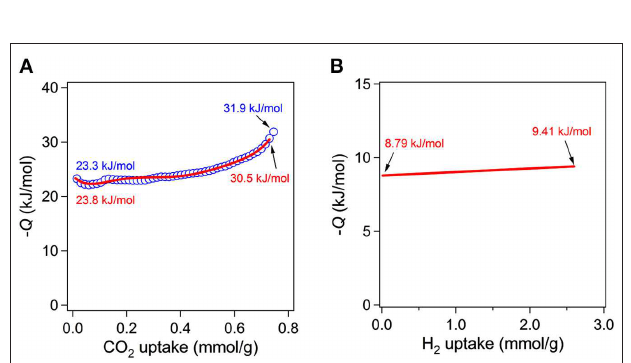
FIGURE 7 | Isosteric heats of CO 2 adsorption as a function of CO 2 uptake estimated from the Clausius-Clapeyron equation (blue open symbols) and virial method (red line) (A) . Isosteric heats of H 2 adsorption as a function of H 2 uptake estimated from the virial method (B)